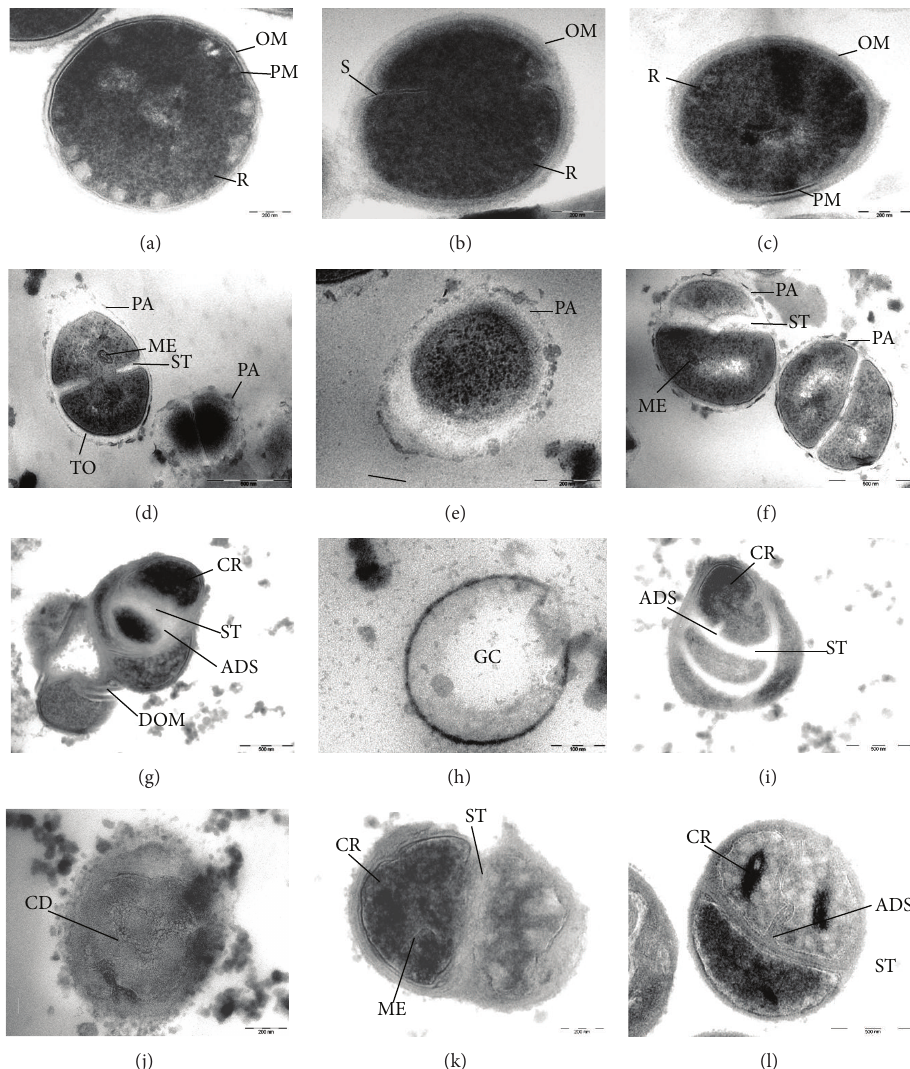
Figure 2: Electron transmission microscope images taken of S. aureus ATCC-33591 cells not treated; (a)–(c) show distinct OM: outer membrane,PM:plasmamembrane,R:ribonucleus,andS:septaofthebacteria.Treatedwithhydroalcoholicextractof Hymenaeastigonocarpa in half of minimum inhibitory concentration; (d)–(f) show indentation and hole formation appearances (PA), mesossomes (M), thickening of theoutermembrane(TO),andseptumthicknessdistribution(ST).Treatedwithminimuminhibitoryconcentration;(g)–(k)showcondensing of the ribonucleus (CR), detachment of outer membrane (DOM), thickness distribution septa (ST) and aberrant division septa (ADS), ghost cells (GC), mesossomes (ME), and coagulated DNA (CD). Magnification of (a), (b), (c), (e), (j), and (k) is 30000x and Magnification of (d), (f), (g), (h) and (l) are